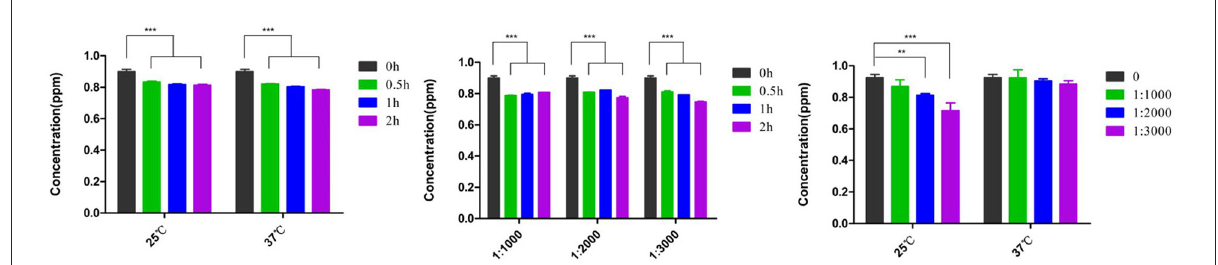
FIGURE3 The detoxification of anti-FB1 monoclonal antibodies at different temperatures and time points. No significant difference in FB1 degradation was found between 25 and 37 ◦ C. A significantly decreasing trend was found in the 1:3,000 anti-FB1 monoclonal antibody-treated group at 25 ◦ C. Moreover, a reverse dose-dependent manner of detoxification was observed post treatment with diverse anti-FB1 monoclonal antibodies at 25 ◦ C. ** p < 0.01 and *** p < 0.001.